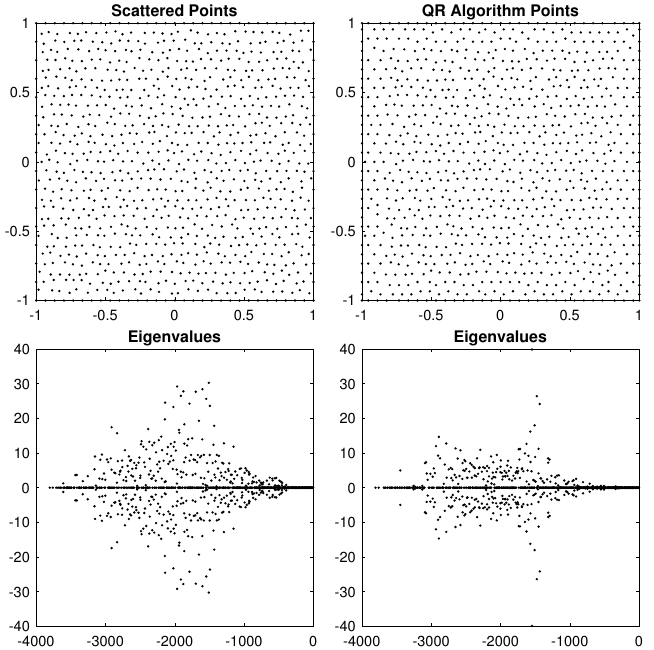
Figure 12. Scattered points and resulting MCpQR algorithm points with Dirichlet Laplacian eigenvalues.